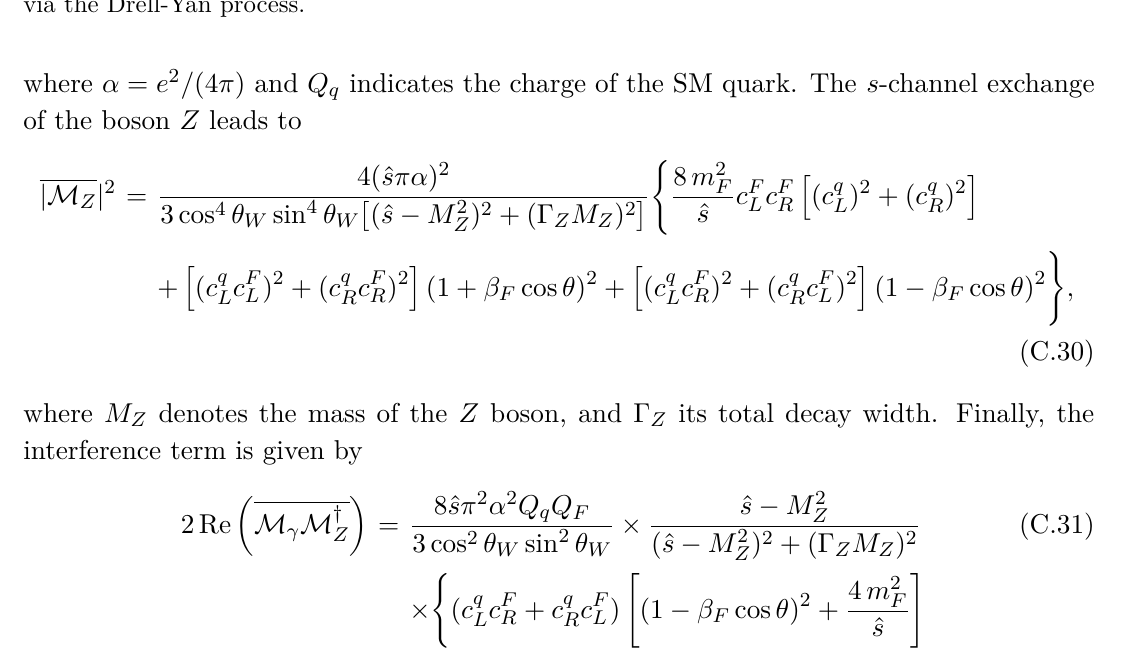
Figure 10 . Feynman diagram for the LO fermion and scalar pair production at hadron colliders via the Drell-Yan